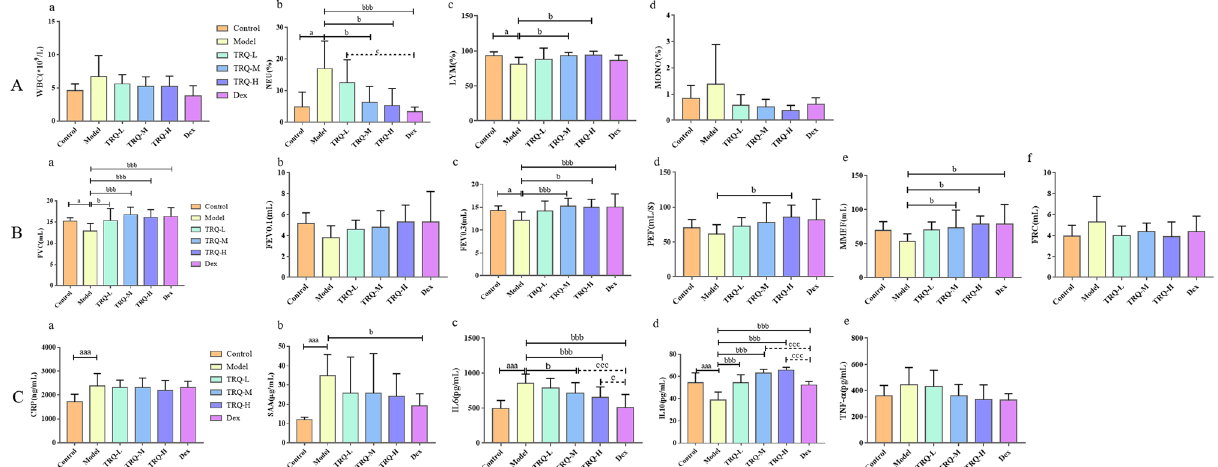
Figure 6. ( A ) Blood cytological analysis in rats to detect the levels of WBC ( a ), NEU ( b ), LYM ( c ) and MONO ( d ). n = 9–12; ( B ). Measuring the relevant indexes of lung function analysis in rats, including FVC ( a ), FEV0.1 ( b ), FEV0.3 ( c ), PEF ( d ), MMEF ( e ), and FRC ( f ). n = 6–12; ( C ). TRQ inhibits inflammatory response in AECOPD rats. TRQ reduced the relevant cytokines level, such as CRP in serum ( a ), SAA in serum ( b ), IL6 in serum ( c ) and TNF-α in BALF ( e ). Moreover, TRQ upregulated the expression level of IL10 in serum ( d ). n = 6–12; a P < 0.05, aaa P < 0.01 vs. the control group; b P < 0.05, bbb P < 0.01 vs. the model group; c P < 0.05, ccc P < 0.05 vs. the Dex group.